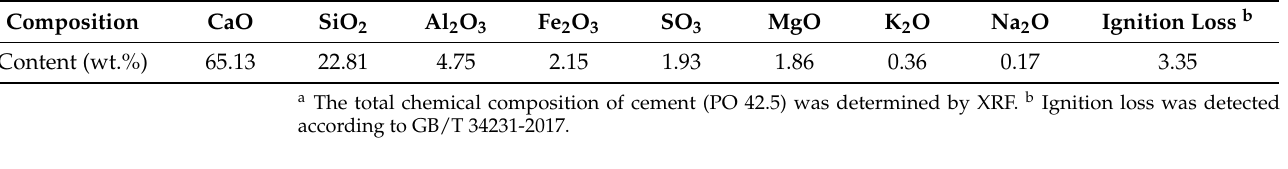
Table 3. Binding energies and atomic composition of the element on the surfaces (depth 1–10